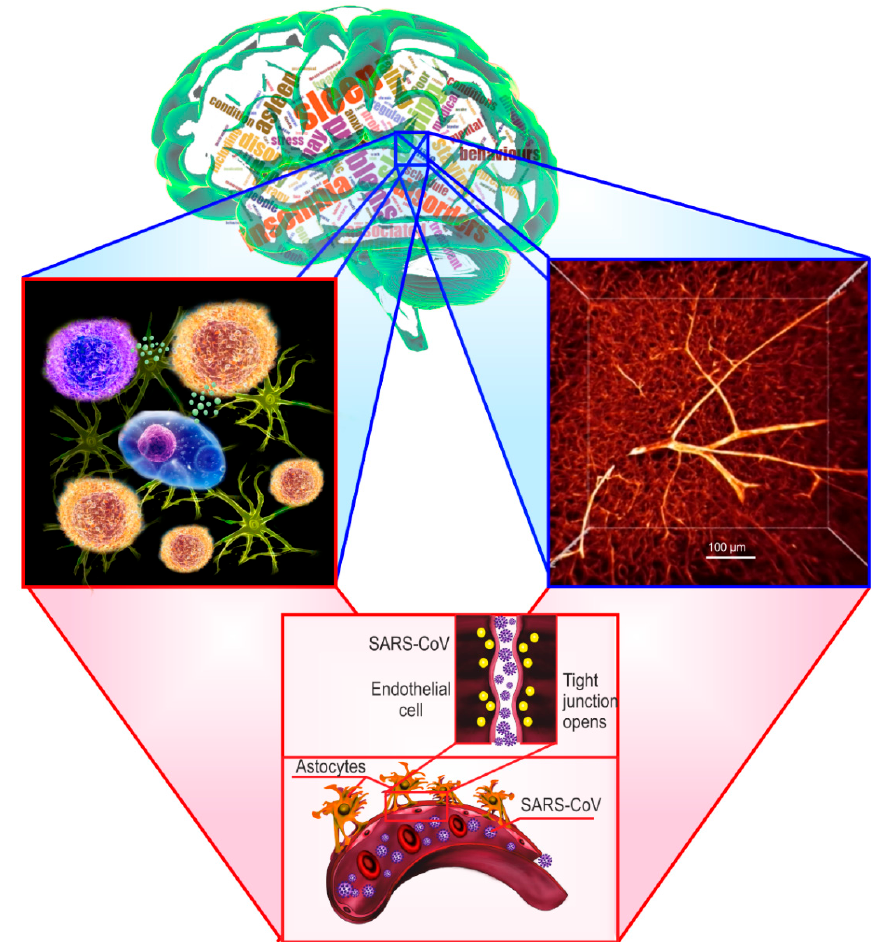
Figure 2. Illustration of the blood–brain barrier (BBB) disruption induced by sleep-related disorders. Middle upper figure demonstrates the various sleep disturbances, including insomnia, sleep deprivation, sleep apnea, associated with the BBB breakdown. The left figure shows that sleep loss causes low-grade inflammation of the brain, which facilitates the BBB disruption. Right (two-photon imaging of the brain capillaries filled by tetramethylrhodamine isothiocyanate–dextran 70 kDa) and the middle lower squares demonstrate the cerebral blood vessels damaged by cytokines leading to the BBB